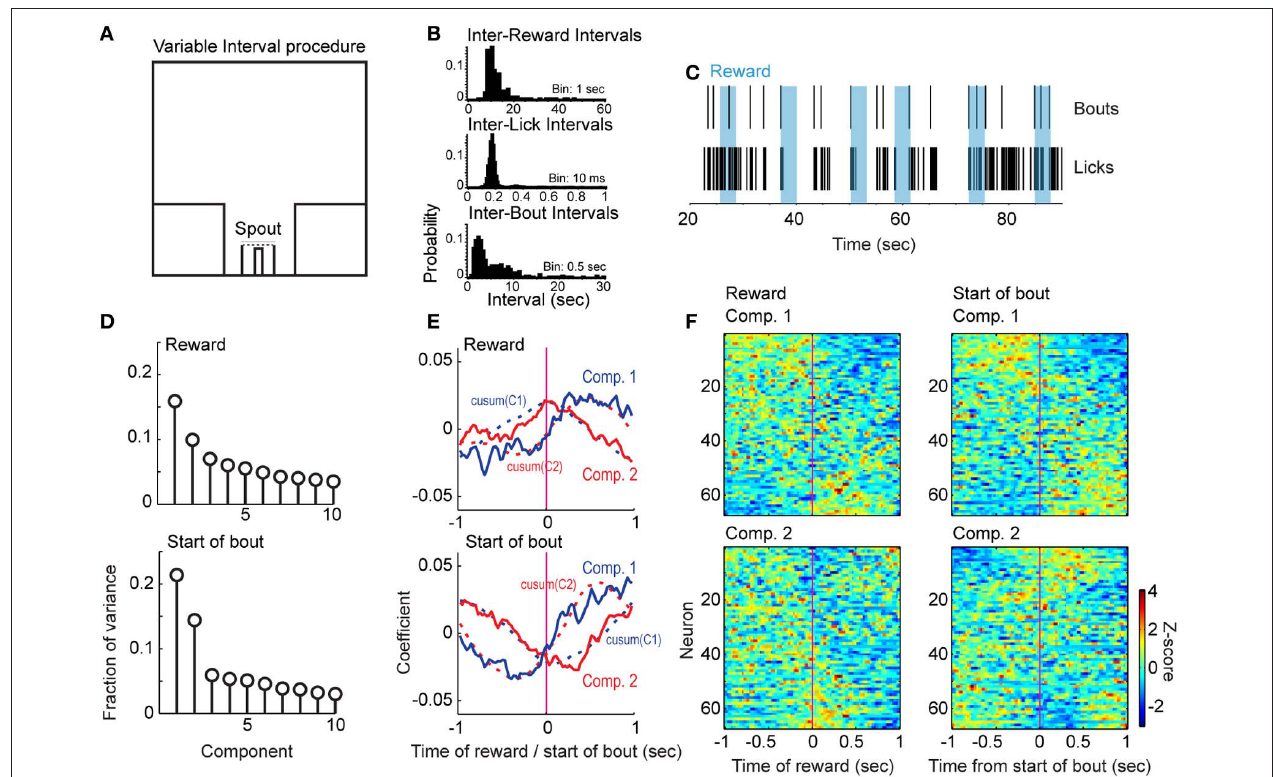
rates in relation to the delivery of reward (top) and the bouts of licks (bottom). More variance was accounted for by the leading Components when the neuronal activity was aligned to the initiation of bouts than to the delivery of reward. (E) Temporal patterns of population activity around reward delivery (top) and the bouts of licks (bottom). The cumulative sums for each Component are also plotted as dashed lines. (F) Patterns in firing rates based on sorting average peri-reward and peri-burst histograms by the loadings for the first and second Components from the population analysis.